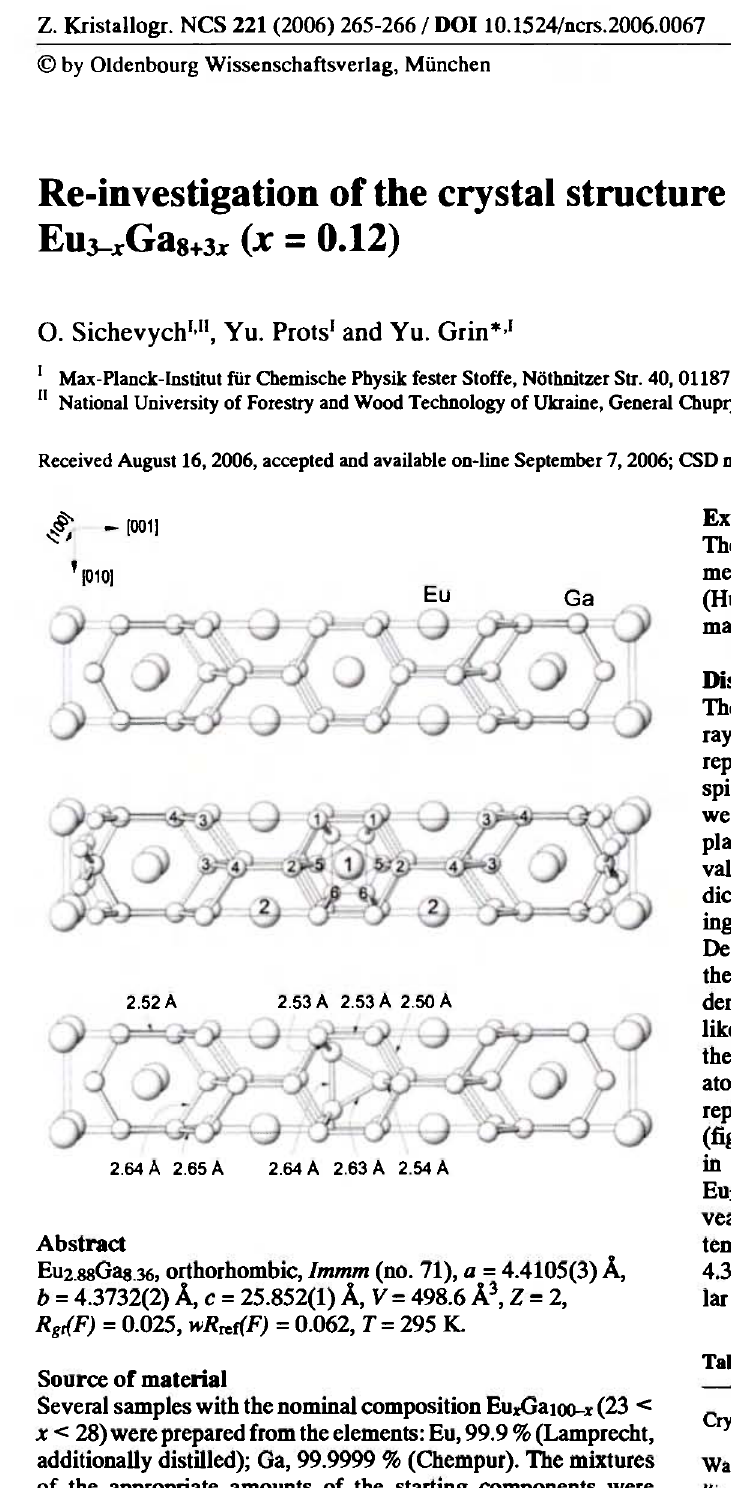
Table 1. Data collection and handling.